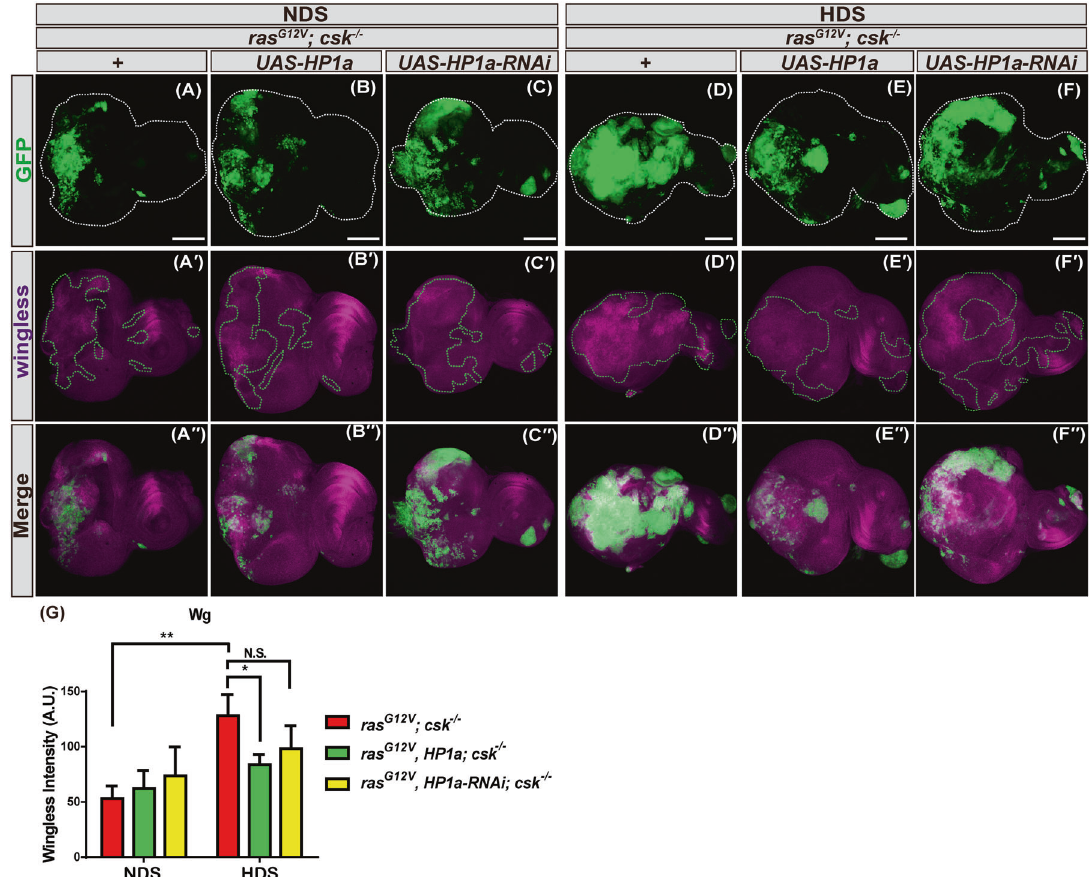
Fig. 6 Increased heterochromatin formation inhibits HDS-induced wingless expression in tumor cells. Third instar eye discs of ras G12V ; csk − / − and ras G12V , HP1a; csk − / − and ras G12V , HP1a-RNAi; csk − / − fl ies fed NDS or HDS with GFP-labeled tumor cells (green) and wingless staining (magenta). Scale bar: 100 μ m. A – A ′′ , D – D ′′ ras G12V ; csk − / − . B – B ′′ , E – E ′′ ras G12V , HP1a ; csk − / − . C – C ′′ , F – F ′′ ras G12V , HP1a-RNAi ; csk − / − . G Quanti fi cation of wingless immuno fl uorescent signal in tumor cells of ras G12V ; csk − / − and ras G12V , HP1a; csk − / − and ras G12V , HP1a-RNAi; csk − / − fl ies fed NDS or HDS. All results analyzed and presented re fl ect data from fi ve independent experiments ( n = 25). Results are shown as mean ± SD of individual eye discs. Asterisks indicate statistically signi fi cant differences via two-way ANOVA with relevant paired controls (* p < 0.05; ** p < 0.01). GFP green fl uorescent protein, HDS high dietary sugar, NDS normal dietary sugar, NS not signi fi